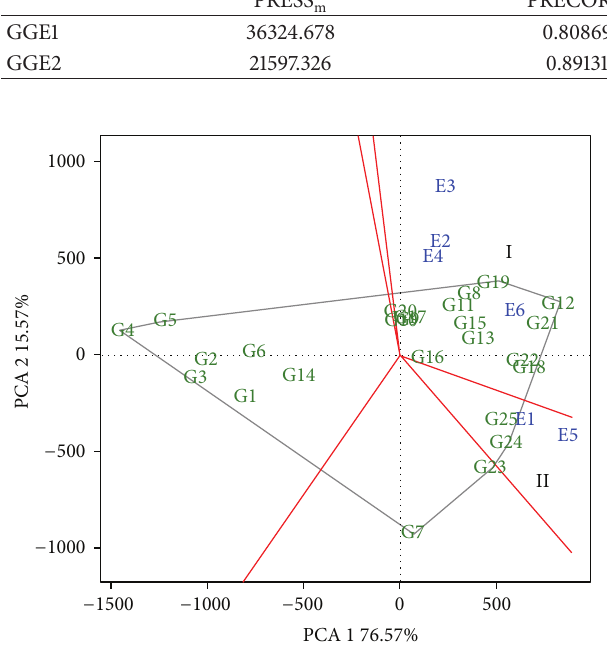
Figure 1: GGE biplot graph, evaluating the GIDI, with the grouping of the six locations (Vacaria, RS; Abelardo Luz, SC; Candoi, PR; Canoinhas,SC;Castro,PR;andPontaGrossa,PR)identifiedfromE1 to E6, respectively, with the groups of environments being identified by the Roman numerals I and II; the gray line represents the polygon formed by genotypes evaluated.